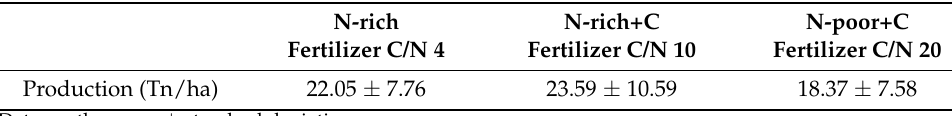
Table 3. Production according to the type of organic fertilization.